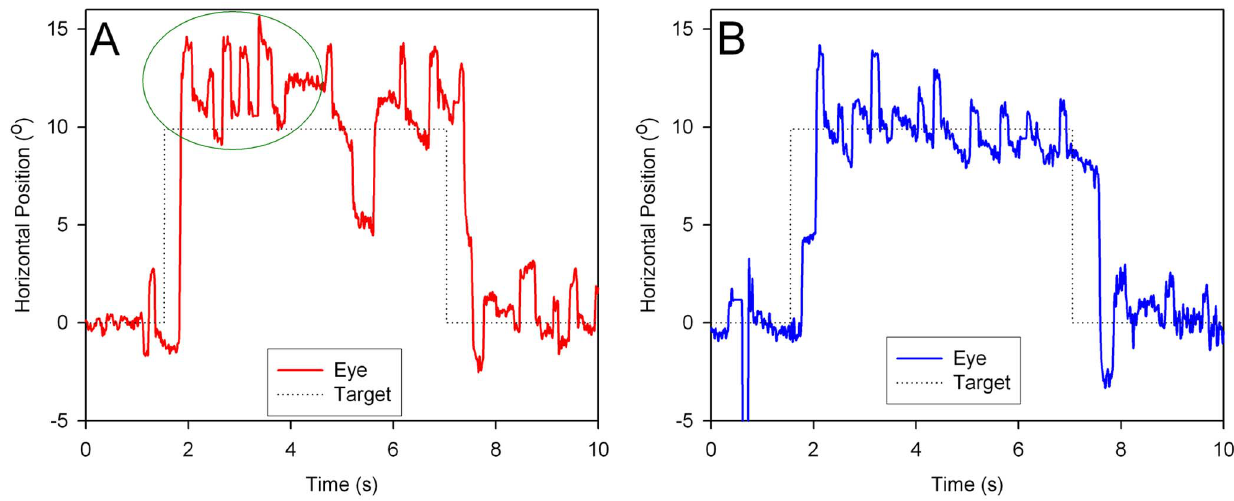
Figure 1. Records of horizontal gaze during a saccade test from Patient 1 before (A) and during (B) treatment. Although saccadic intrusions are present during the periods of fixation on the center target (evident at the beginning and end of the figure), the greatest frequency of intrusions occurs following the rightward saccade at about 2 seconds into the record (highlighted within the ellipse). During treatment with memantine, saccadic intrusions are still present, but tend to be smaller, less frequent and do not increase after the rightward saccade. Positive values indicate rightward eye and target movements.